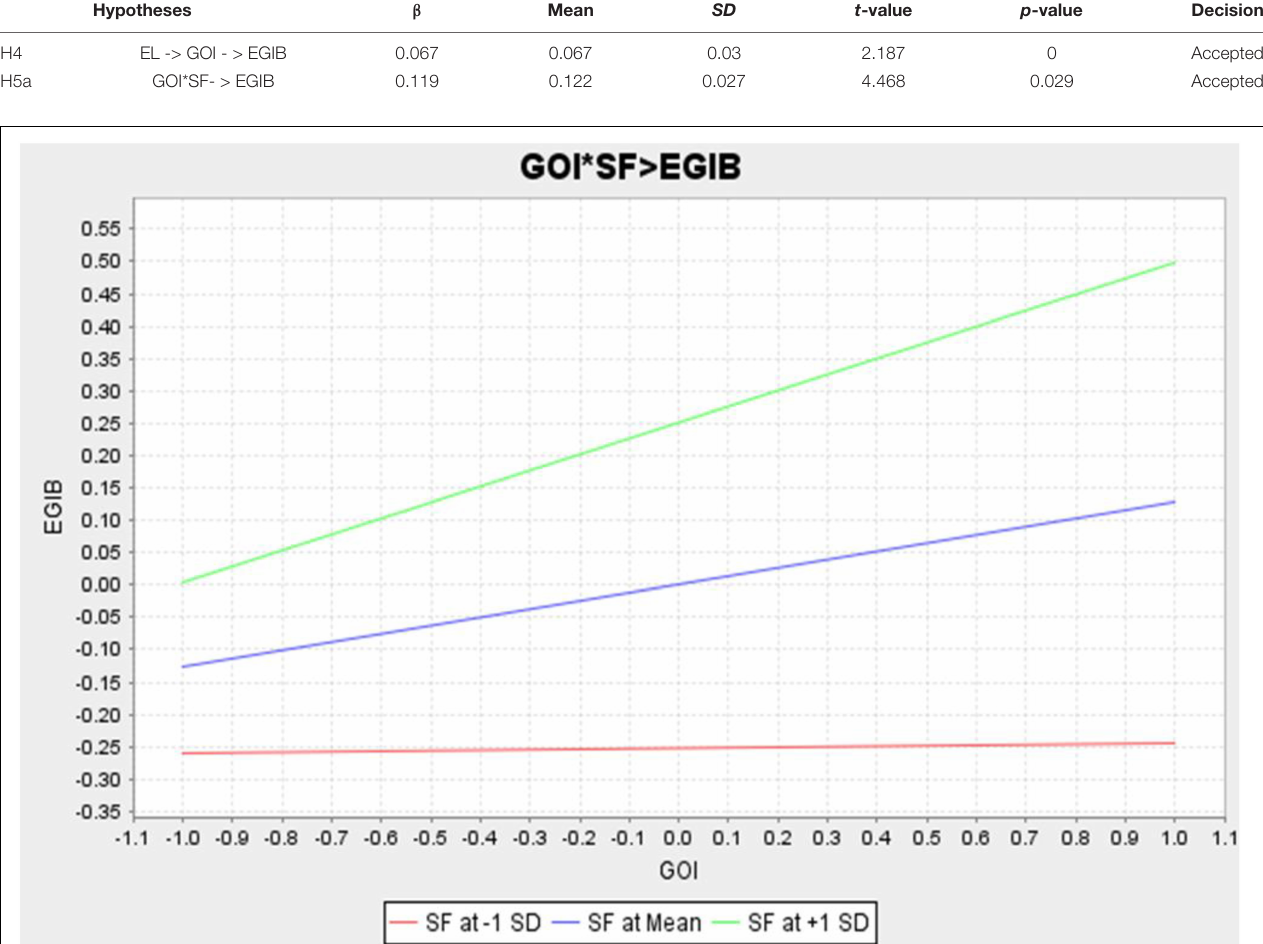
TABLE 6 | Indirect impacts of all studied variables.